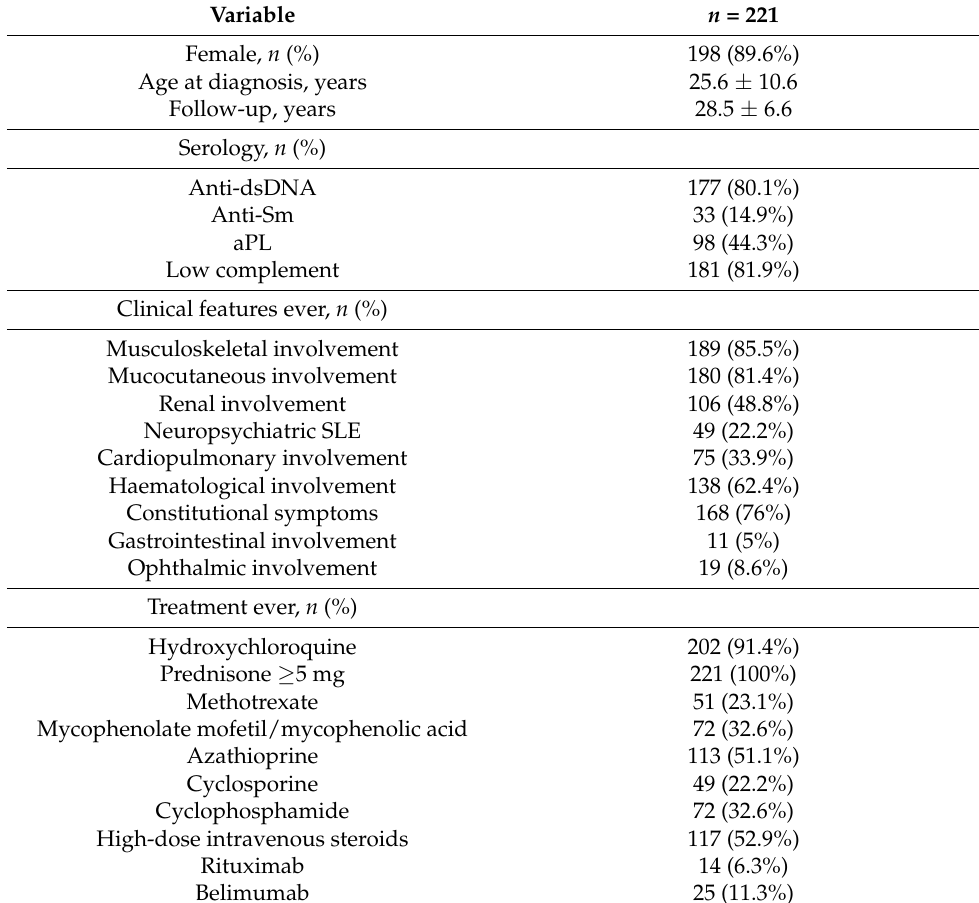
Table 1. Clinical, laboratory and demographic